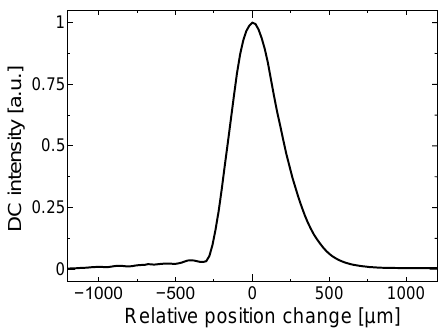
Figure 7. The fluctuation of DC signal intensity with measurement surface displacement. With tracking OFF, the change in DC signal influences perfusion spectra through the heterodyne effect.